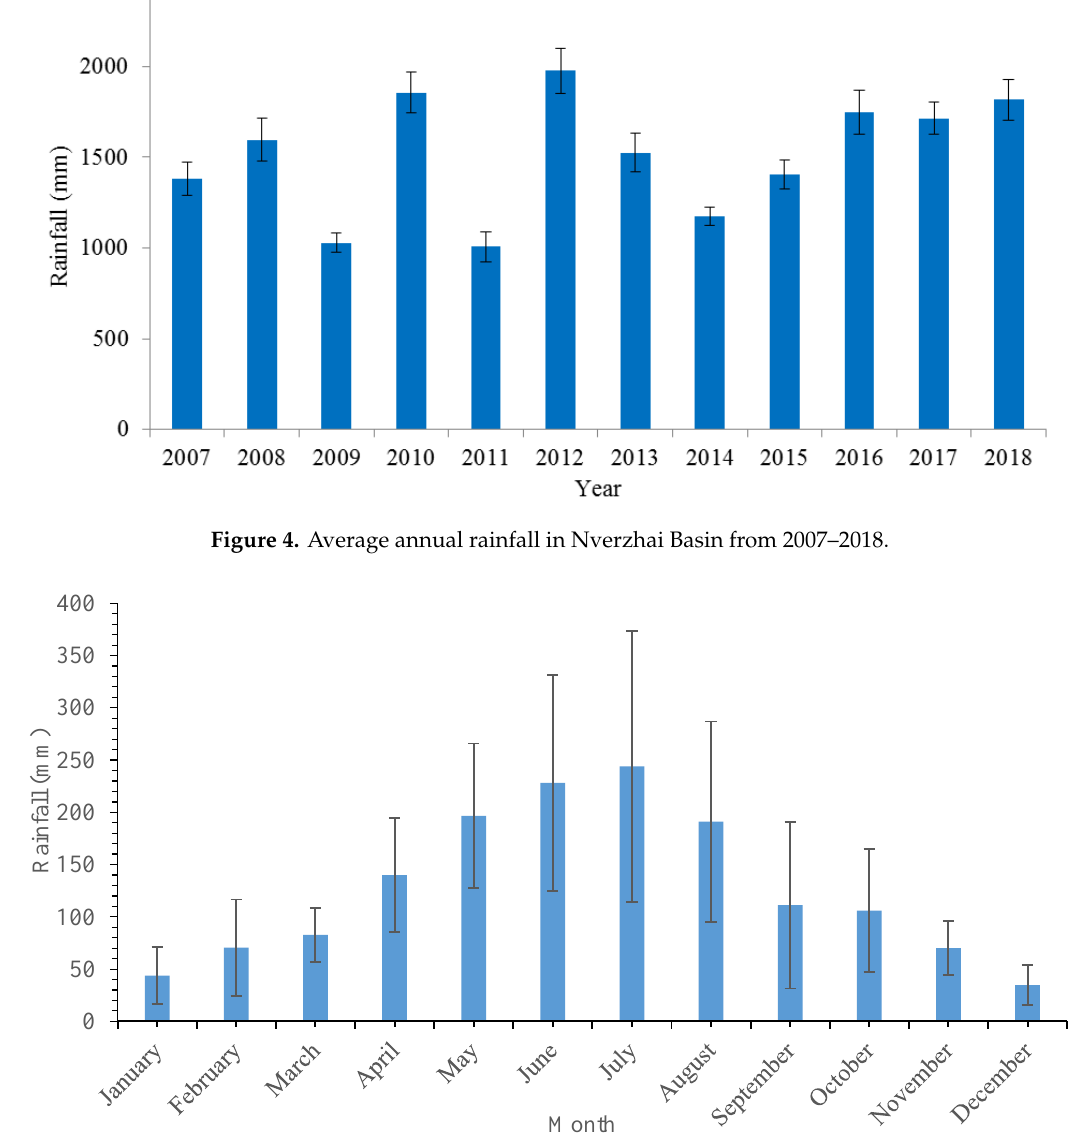
Figure 6. Percentage (%) of vegetation types from 2007 to 2018.